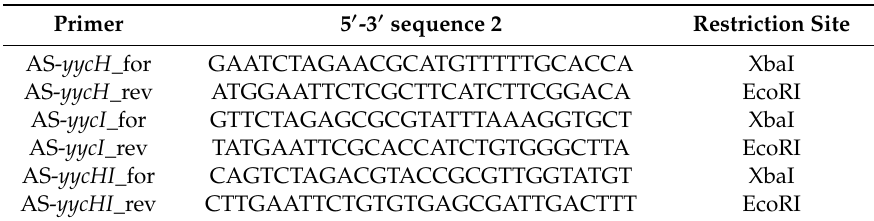
Table 1. Primers used in this